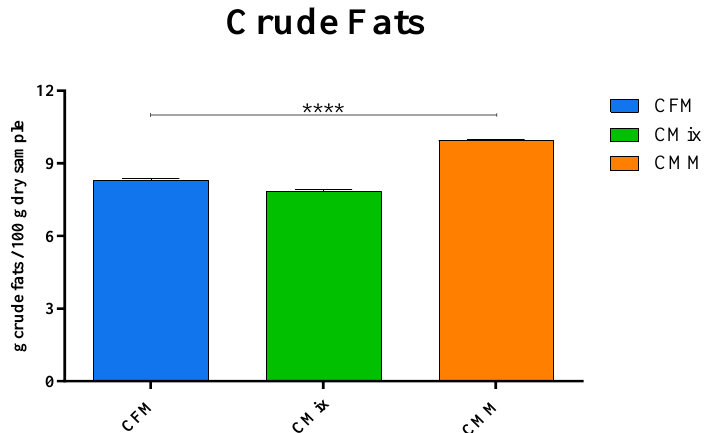
Figure 2. The crude fat content of CFM, CMix, and CMM formulations for companion animal food. Data are reported as mean ± SEM, n = 12. **** p < 0.0001.